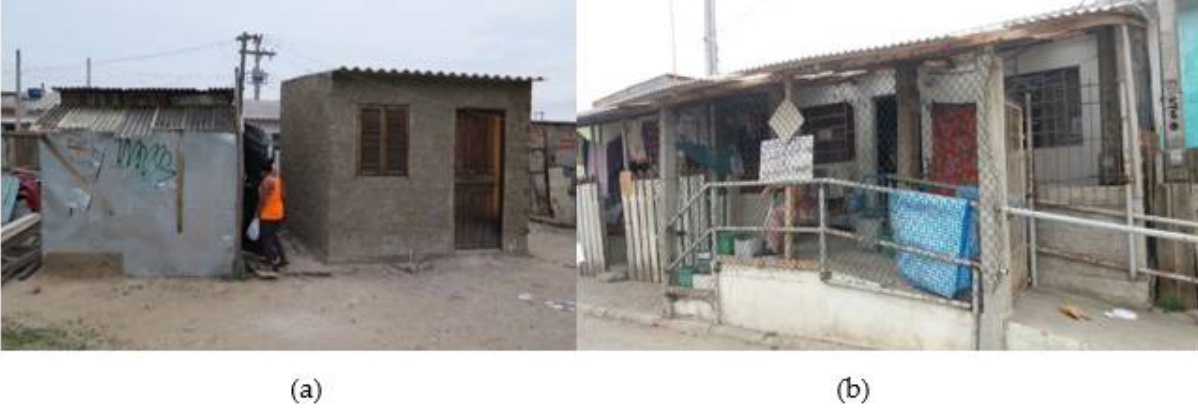
Figure 3. Examples of expansions encroaching onto the public space in the Anglo development: ( a ) advancing onto the neighborhood’s green area, and ( b ) advancing over the sidewalk. Photos by NAUrb-UFPel [38].